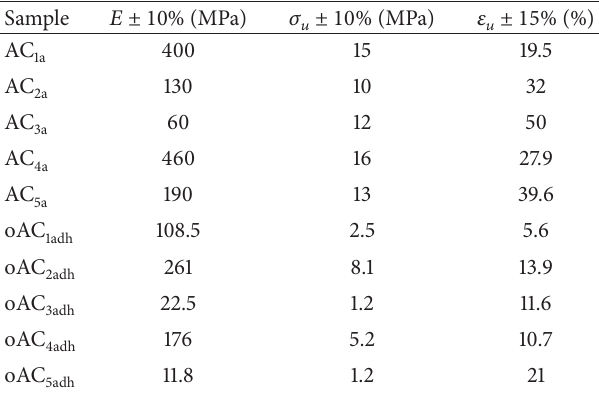
Table 4: Mechanical data of hydrogels films partially (AC and complete calcium cross-linked (AC cross-linked ones